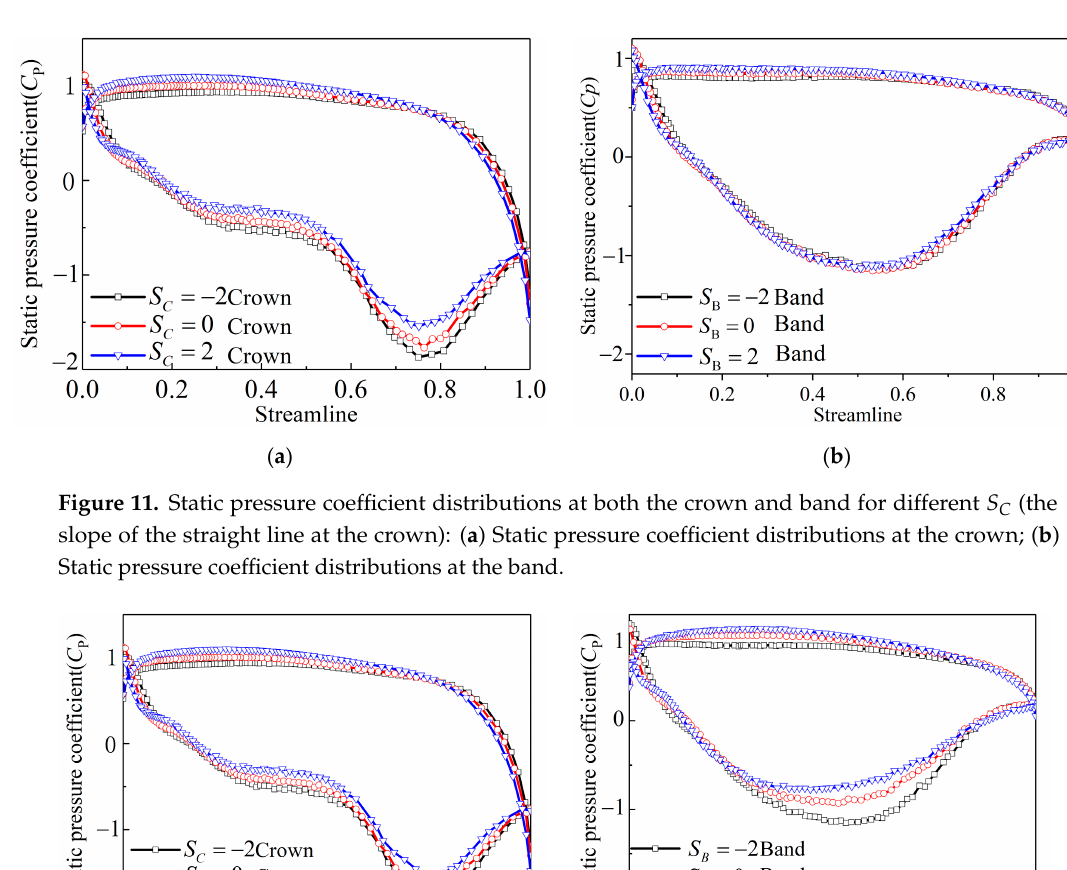
Figure 12. Static pressure coefficient distributions at both the crown and band for different S B (the